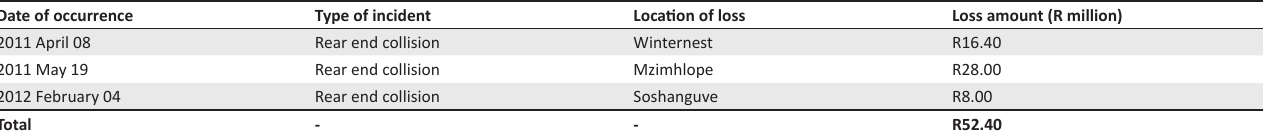
TABLE 2: Gauteng Province selected incidents location and amount lost.